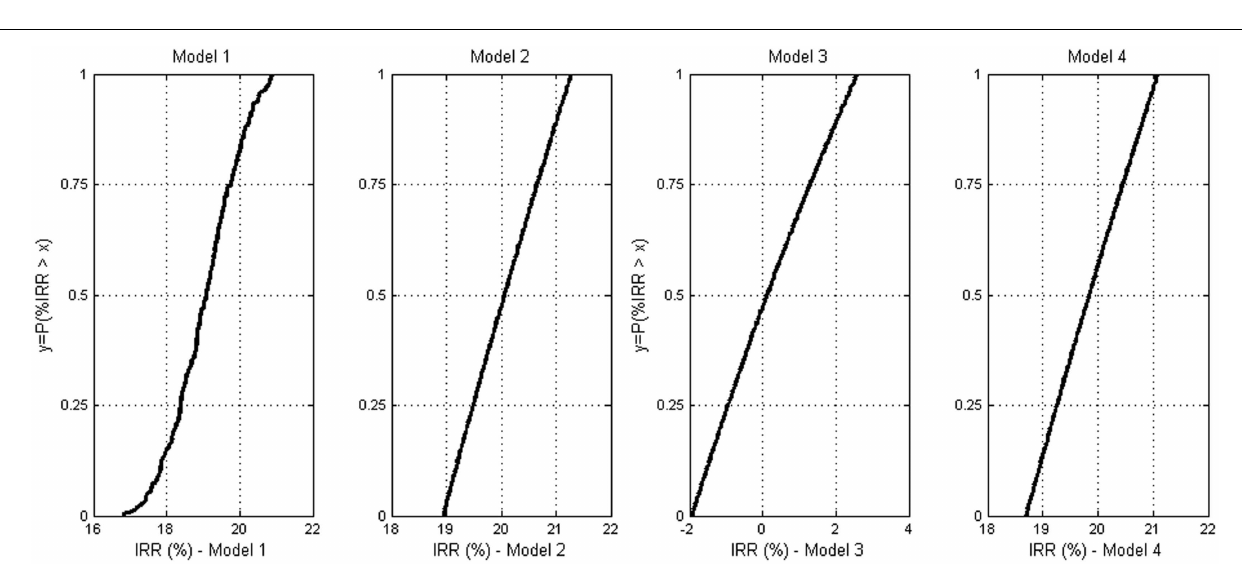
FIGURE 6 | 1,3-Butadiene production: the empirical cumulative distribution function (ECDF) of the IRR estimated from four estimation models .